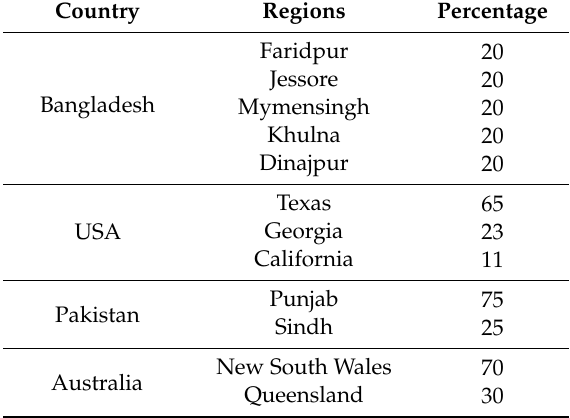
Table A7. Percentage of cotton grown in di ff erent regions of Bangladesh, USA, Pakistan and Australia [76–78].